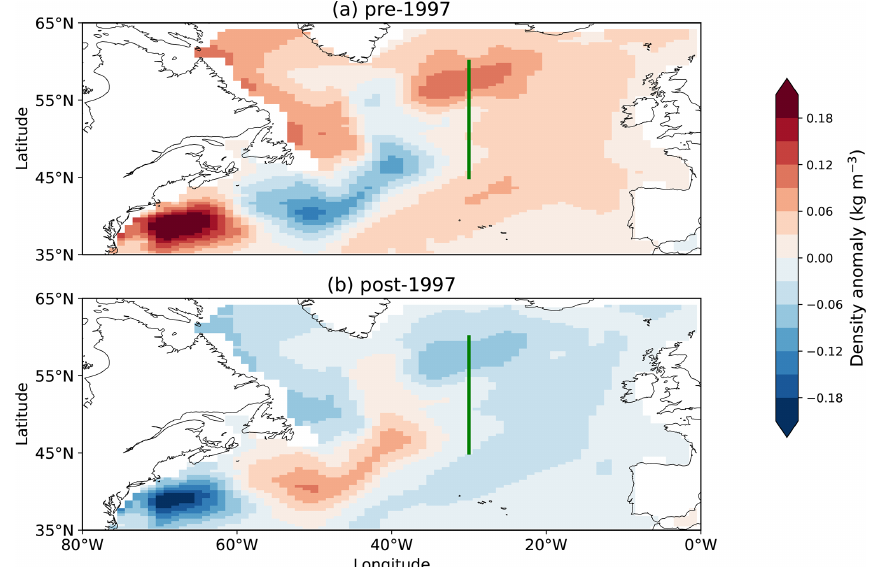
Figure 2. Mean anomaly maps of density at 205m below the surface: (a) pre-1997; (b) post-1997. Data from GODAS. Anomalies calculated with respect to the 1980–2020 climatology. The green line at 30 ◦ W shows the meridional profile used for eastward transport calculations between 45 and 60 ◦